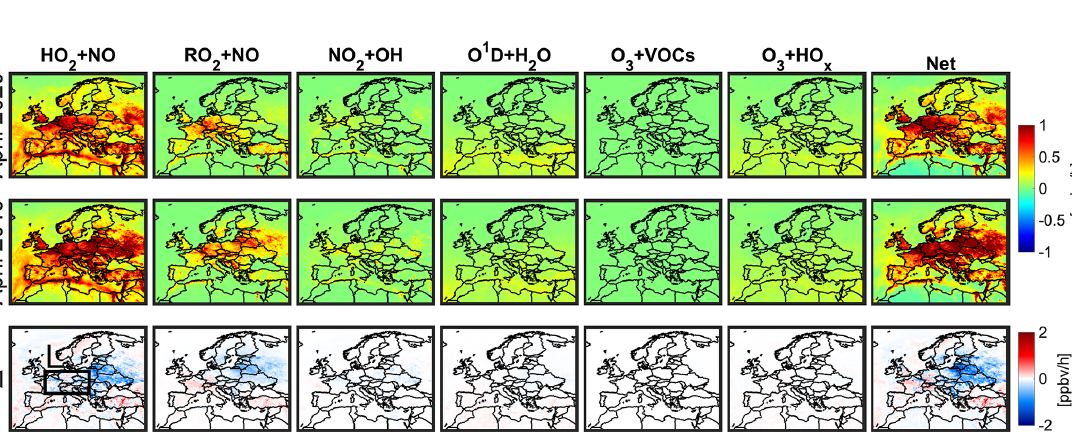
Figure 11. Surface chemical processes involved in Eq. (6) (ppbv/h) pertaining to the production and loss of ozone in April 2020 (lockdown) and 2019 (baseline) during MDA8 hours. These outputs are based on the constrained